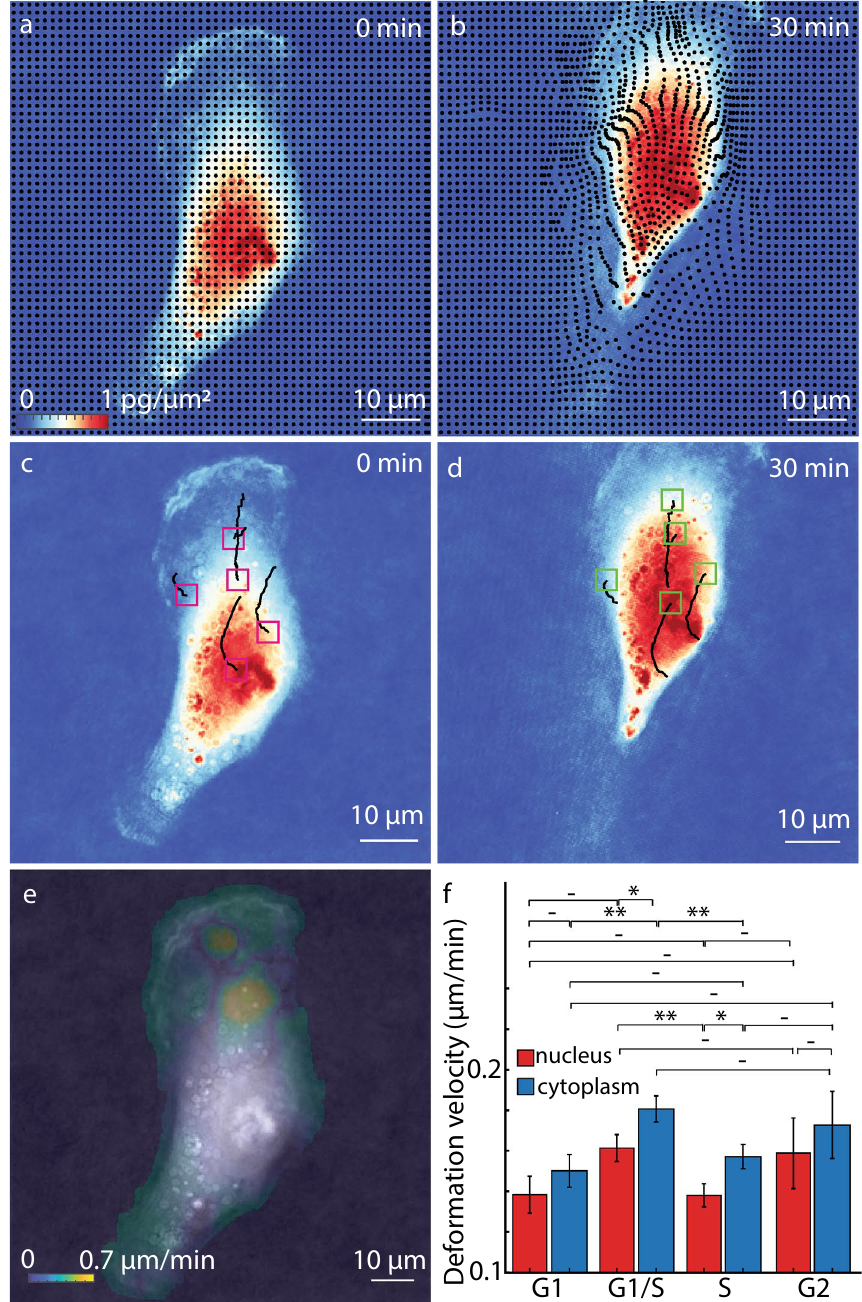
Figure 4. QPV shows spatial and temporal dynamics of biomass motion within cells. ( a ) Grid markers depict 4 by 4 pixel intracellular volume centroids overlayed on an RPE cell at 120 X magnification ( b ) which deforms from ( a ) to ( b ) due to movement of the cells over 30 min. ( c ) Dry mass inside control volumes initial positions marked using magenta boxes travel along the black line to reach the final positions indicated using green boxes in ( d ) in 30 min. ( e ) Deformation velocity, the whole cell velocity subtracted intracellular velocity distribution of dry mass, inside the RPE cell, gives the magnitude of the deviation of each cell volume’s motion from its expected position. ( f ) Deformation velocity of dry mass in nucleus and cytoplasm of RPE cells, indicating magnitude of the local cell deformation, shows higher deformation in the cytoplasm than in the nucleus ( n = 59, error bars show standard error of the mean). * p < 0.05 , ** p <